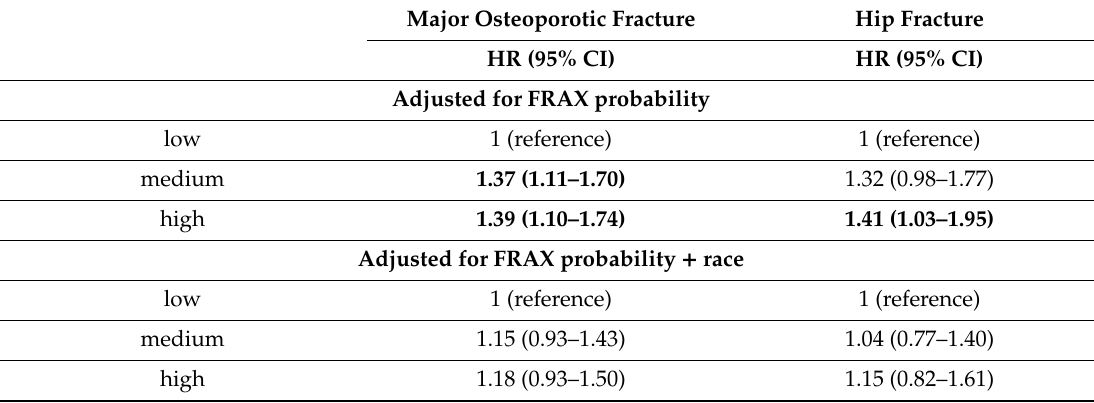
Table A1. Hazard ratios (HR) with 95% confidence interval (CI) for outcomes of Incidence fracture according to the GRS group, adjusted for FRAX score: results from sensitivity analysis after excluding subjects who received intervention in either of the three clinical trials. ( n =